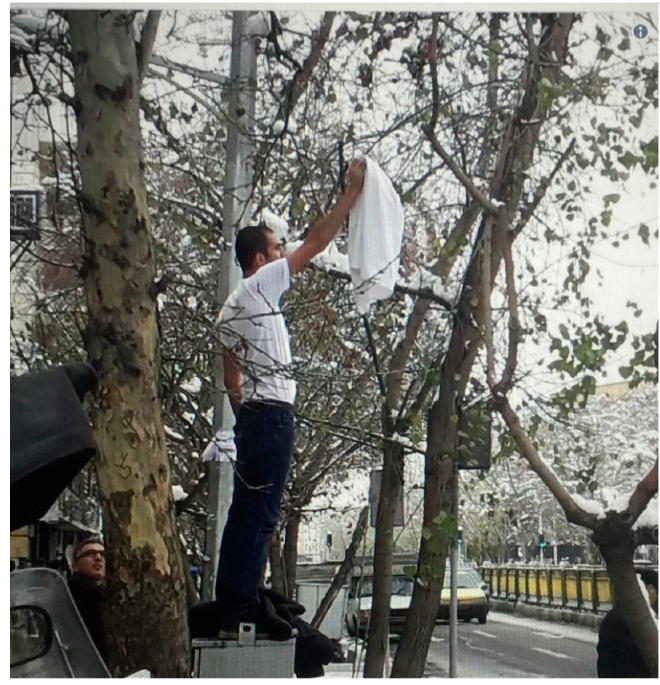
Figure 8. Aman in support of White Wednesday waving a white scarf. Source: https://www.cbc.ca/radio/thecurrent/the-current-for-january-31-2018-1.4510938/iranian-women-risk- arrest-as-they-remove-their-veils-for-whitewednesdays-1.4510942.